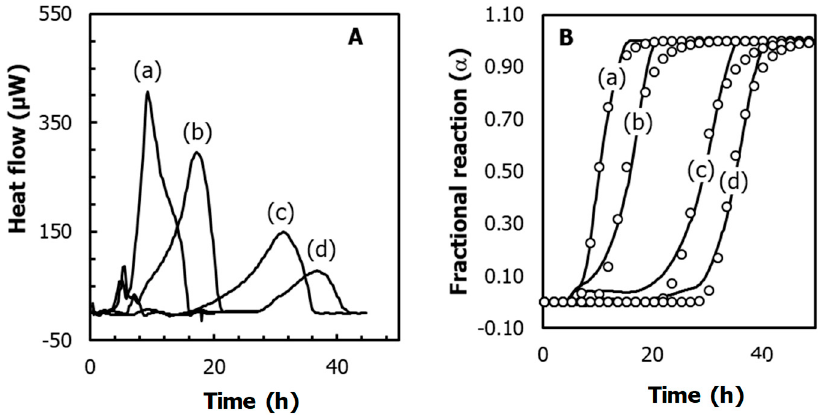
Figure 3. Effect of different concentrations of Picea abies extracts: (a) 0 mg/L, (b) 1 mg/mL, (c) 3 mg/mL, and (d) 5 mg/mL, on ( A ) the heat-flow calorimetric traces and ( B ) the fractional reaction. Experimental conditions as in Figure 2.